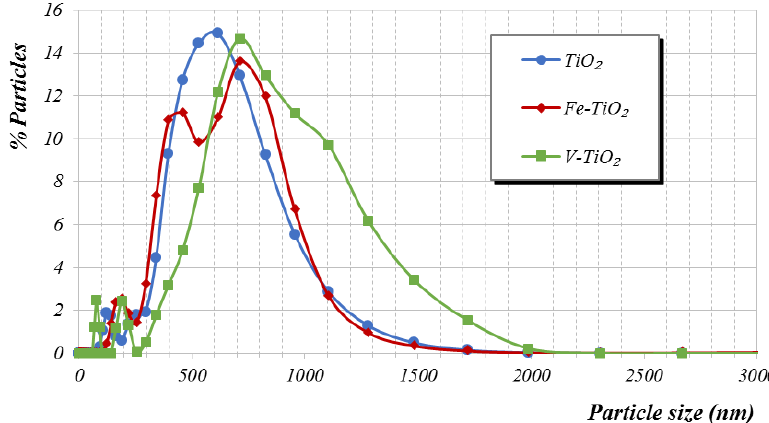
Figure 2. Particle size distribution obtained by light dispersion of the nano-structured photocatalytic additives in an alkaline solution (synthetic pore cement solution, pH 12.5 and 1 wt. % of CaCl 2 ).